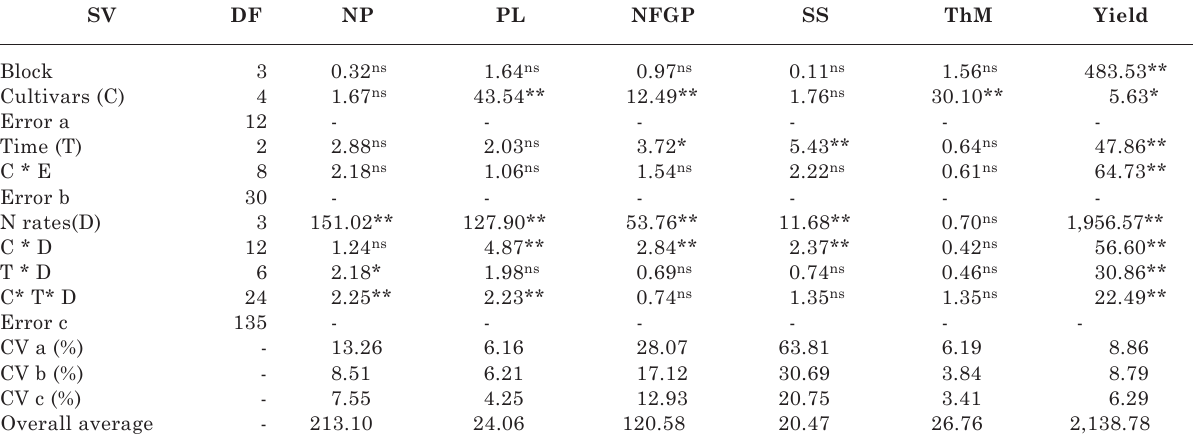
table 1. values of f calculated from the analysis of variance for number of panicles per m 2 (nP), panicle length (Pl), number of filled grains per panicle (nfgP), percentage of sterile spikelets per panicle (ss), 1000-grain mass (thm) and grain yield